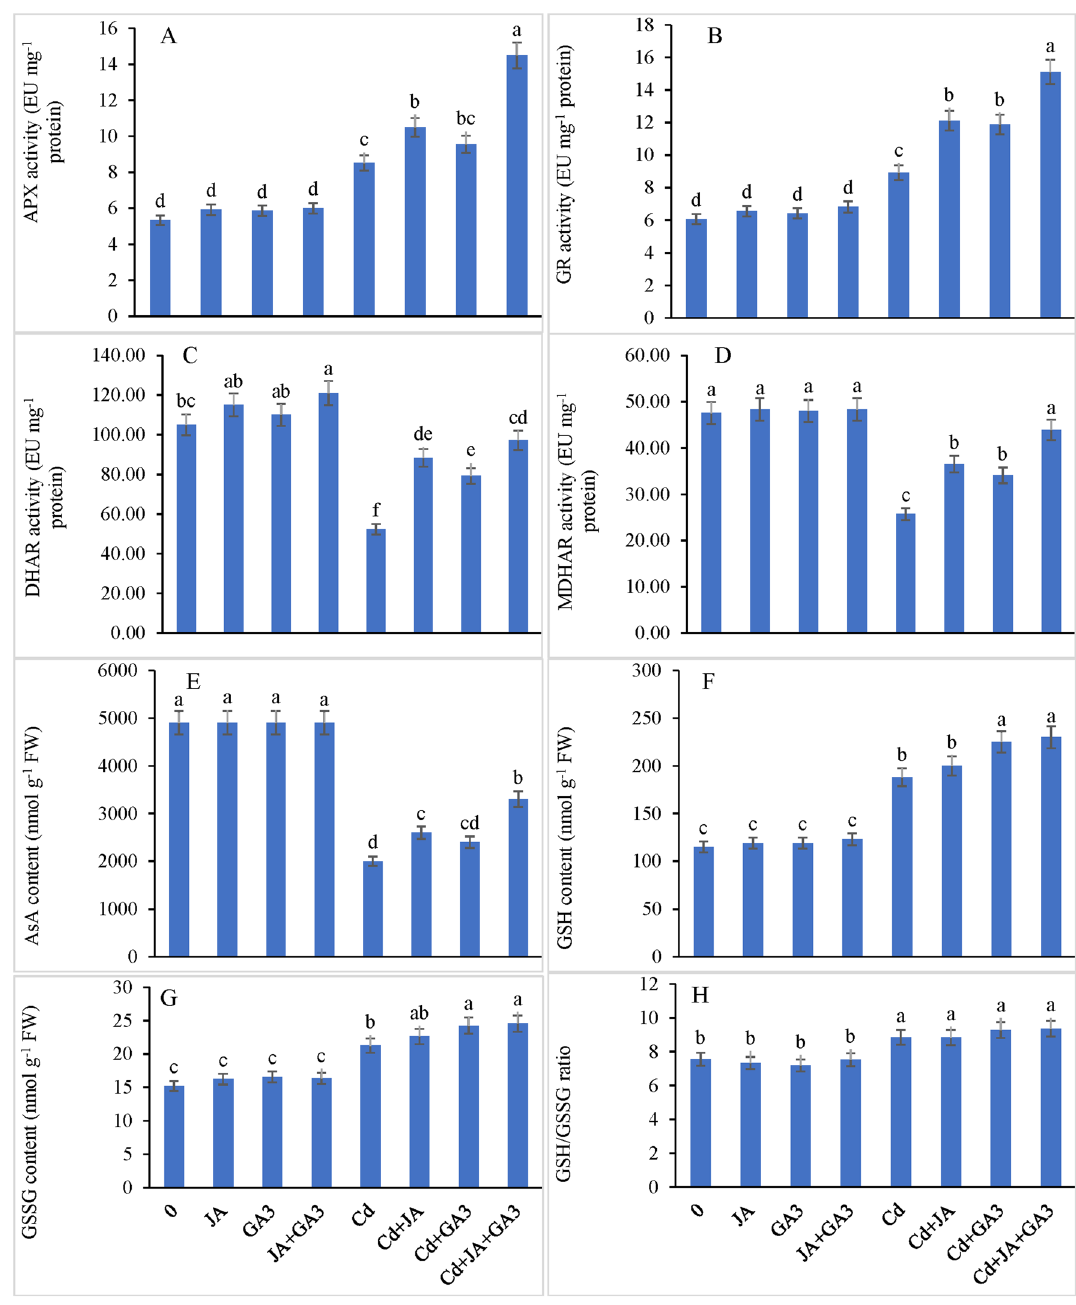
Figure 4. Supplementation of JA and GA 3 individually and/or in combination enhanced the activities of the ascorbate–glutathione cycle enzymes, ( A ) APX: ascorbate peroxidase, ( B ) GR: glutathione reductase, ( C ) DHAR: dehydroascorbate reductase, ( D ) MDHAR: monodehydroascorbate reductase, ( E ) AsA: ascorbic acid content, ( F ) GSH: reduced glutathione, ( G ) GSSG: oxidized glutathione, and (H) GSH/GSSG ratio in Cd-stressed chickpea plants (Mean ±